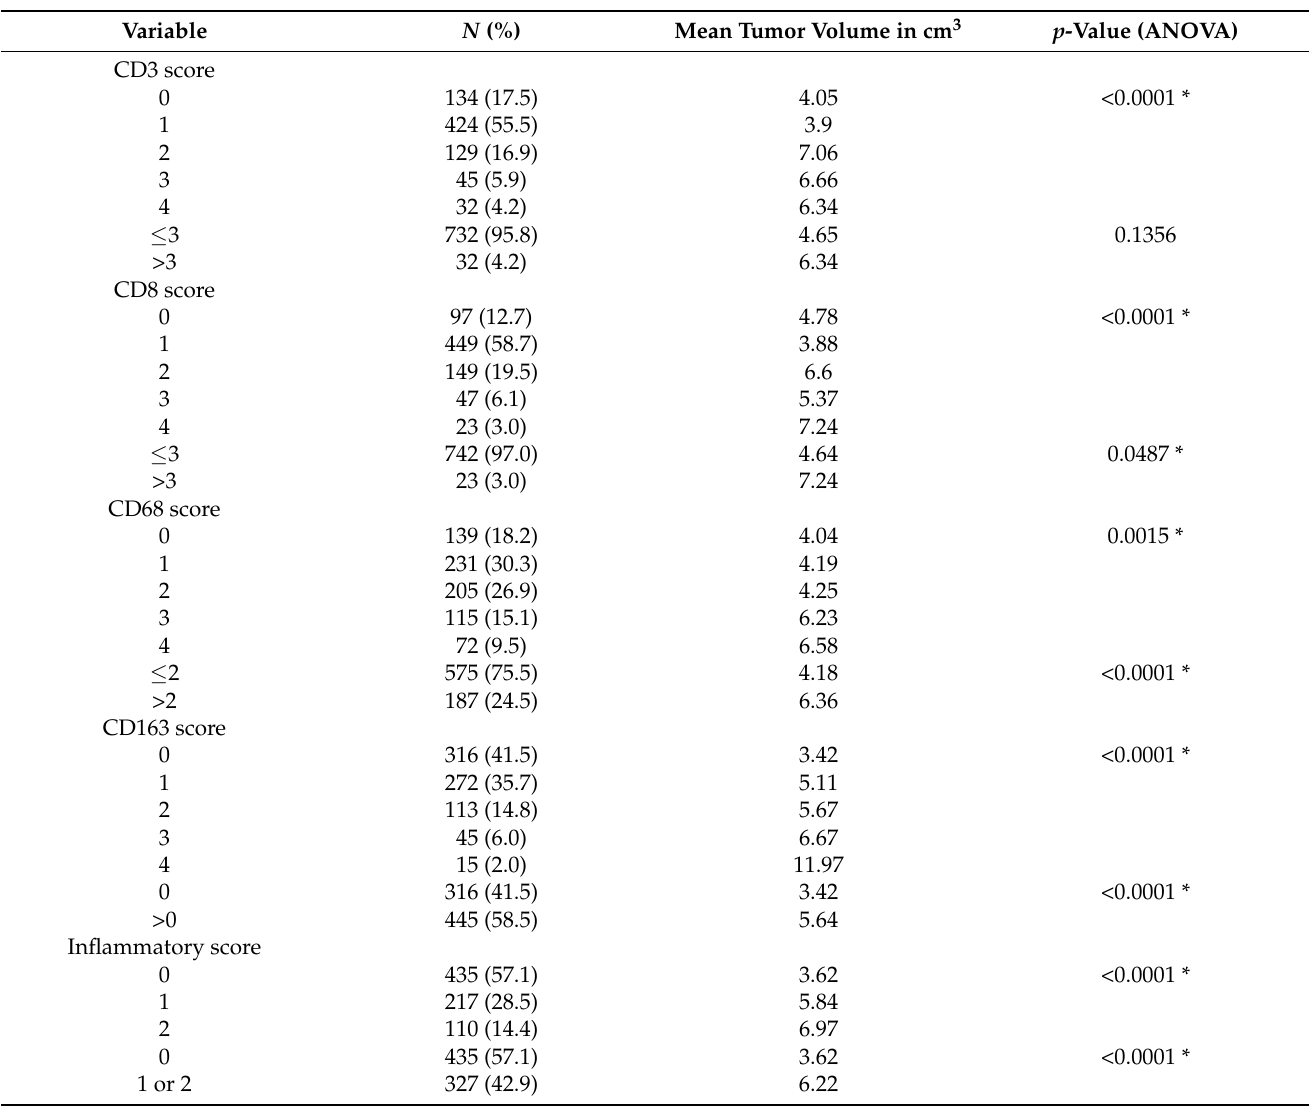
Table 1. Preoperative volumetry according to inflammatory cell marker